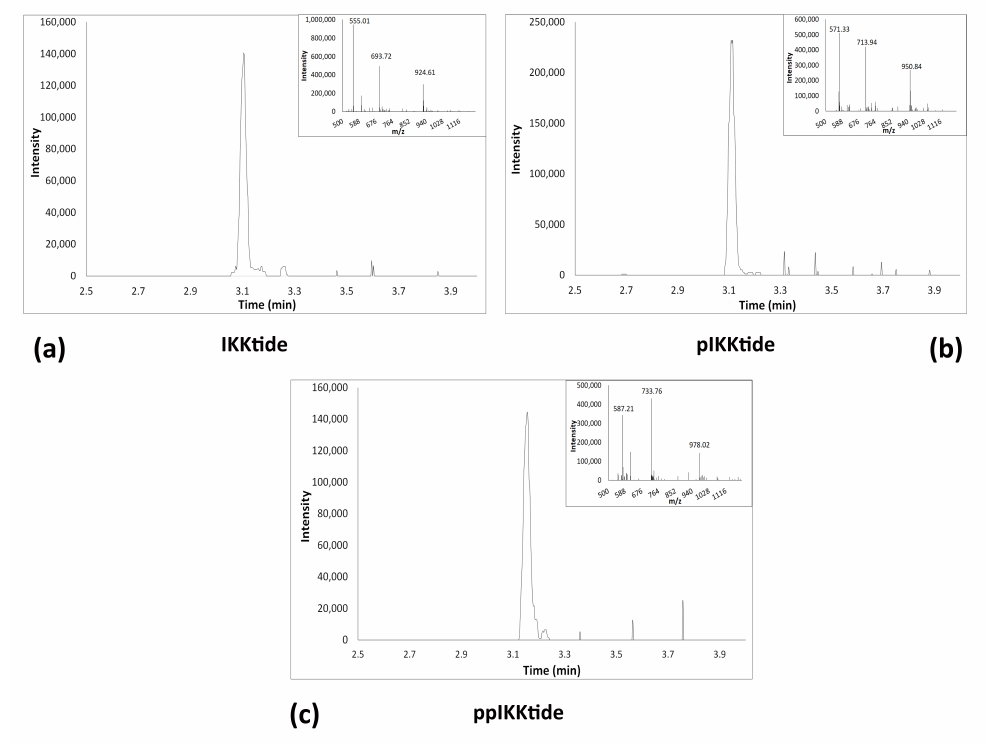
Figure 1. UPLC/MS chromatographic analysis of the three peptides IKKtide, pIKKtide and ppIKK- tide. ( a ) unphosphorylated IKKtide peptide ( b ) monophosphorylated pIKKtide peptide on Ser32; ( c ) di-phosphorylated ppIKKtide on Ser32 and Ser36.